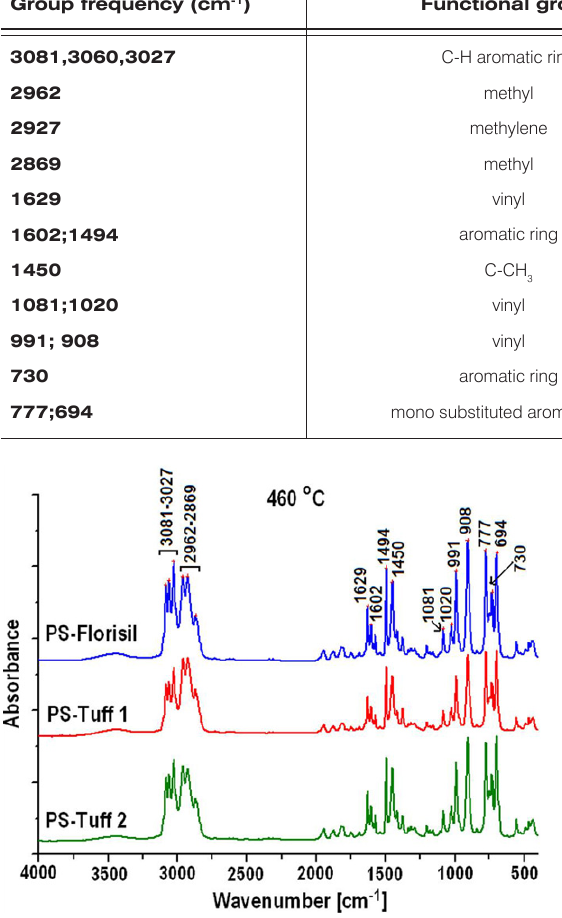
Figure 9. FTIR spectra of liquid products obtained by thermal degradation at 460°C of PS in presence of studied catalysts.